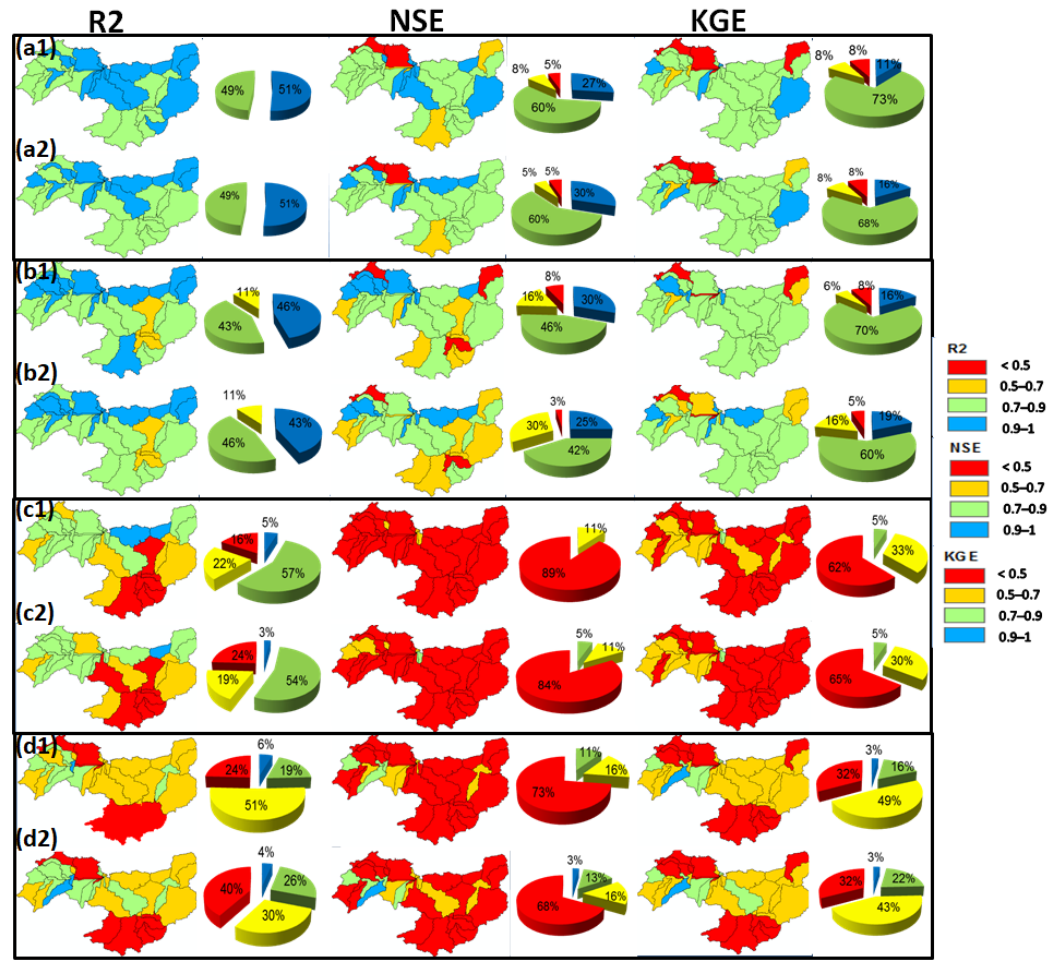
Figure A1. Spatial distribution of performance metrics (R 2 , NSE, and KGE) of SWAT ETa based on P-M when calibrated in 2009 against ETMonitor, GLEAM, WaPOR, and SSEBop ( a1 , b1 , c1 , d1 ), respectively, and SWAT ETa based on P-T when calibrated in 2009 against ETMonitor, GLEAM, WaPOR, and SSEBop ( a2 , b2 , c2 , d2 ), respectively.